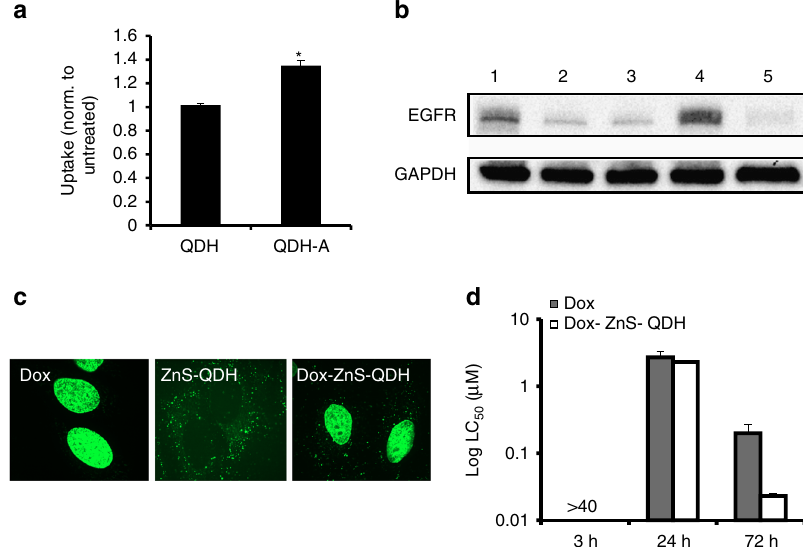
Fig. 5 Cell-speci fi c targeting, siRNA transfection, and Dox delivery using QDHs. a Cell-speci fi c targeting with aptamer in CCL-119 cells. Uptake of QDH and QDH-A were measured using fl ow cytometry. One-way ANOVA, * P < 0.05. b Determination of siRNA delivery with QDH. EGFR was knocked down in HeLa cells with: lane 1: Untreated; 2: EGFR siRNA; 3: EGFR siRNA-aptamer; 4: silencer; 5: QDH-EGFR siRNA. c Cellular localization of Dox, ZnS-QDH, and Dox-ZnS-QDH. d Comparison of LC 50 values of Dox and Dox-ZnS-QDH at 3, 24, and 72 h. All error bars represent s.e.m. ( n = 4). See Supplementary Fig. 8 for full